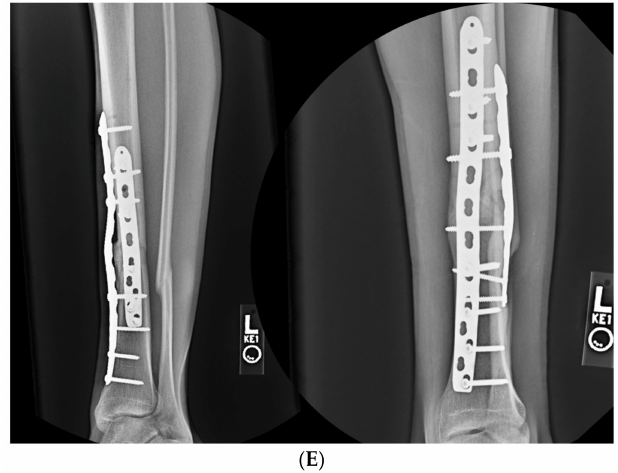
Figure 7. ( A ) A young adult college baseball player sustained a closed tibia fracture with intact fibula, treated closed. The patient developed a recurvatum deformity with pain at the proximal and distal tibiofibular joints. ( B ) The patient demonstrated mechanical axis lateralization due to coronal plane translation with slight varus. The plane of deformity was calculated as 73 degrees off of the coronal plane. ( C ) The patient underwent focal dome osteotomy at the CORA (yellow circle) in the plane of maximum deformity. ( D ) Dual plate compression was used. Angulation and translation were simultaneously corrected. ( E ) Final follow-up 9 months: anteroposterior, lateral, and oblique films show the osteotomy healed. Tibiofibular joint pain resolved after osteotomy. Patient returned to college-level